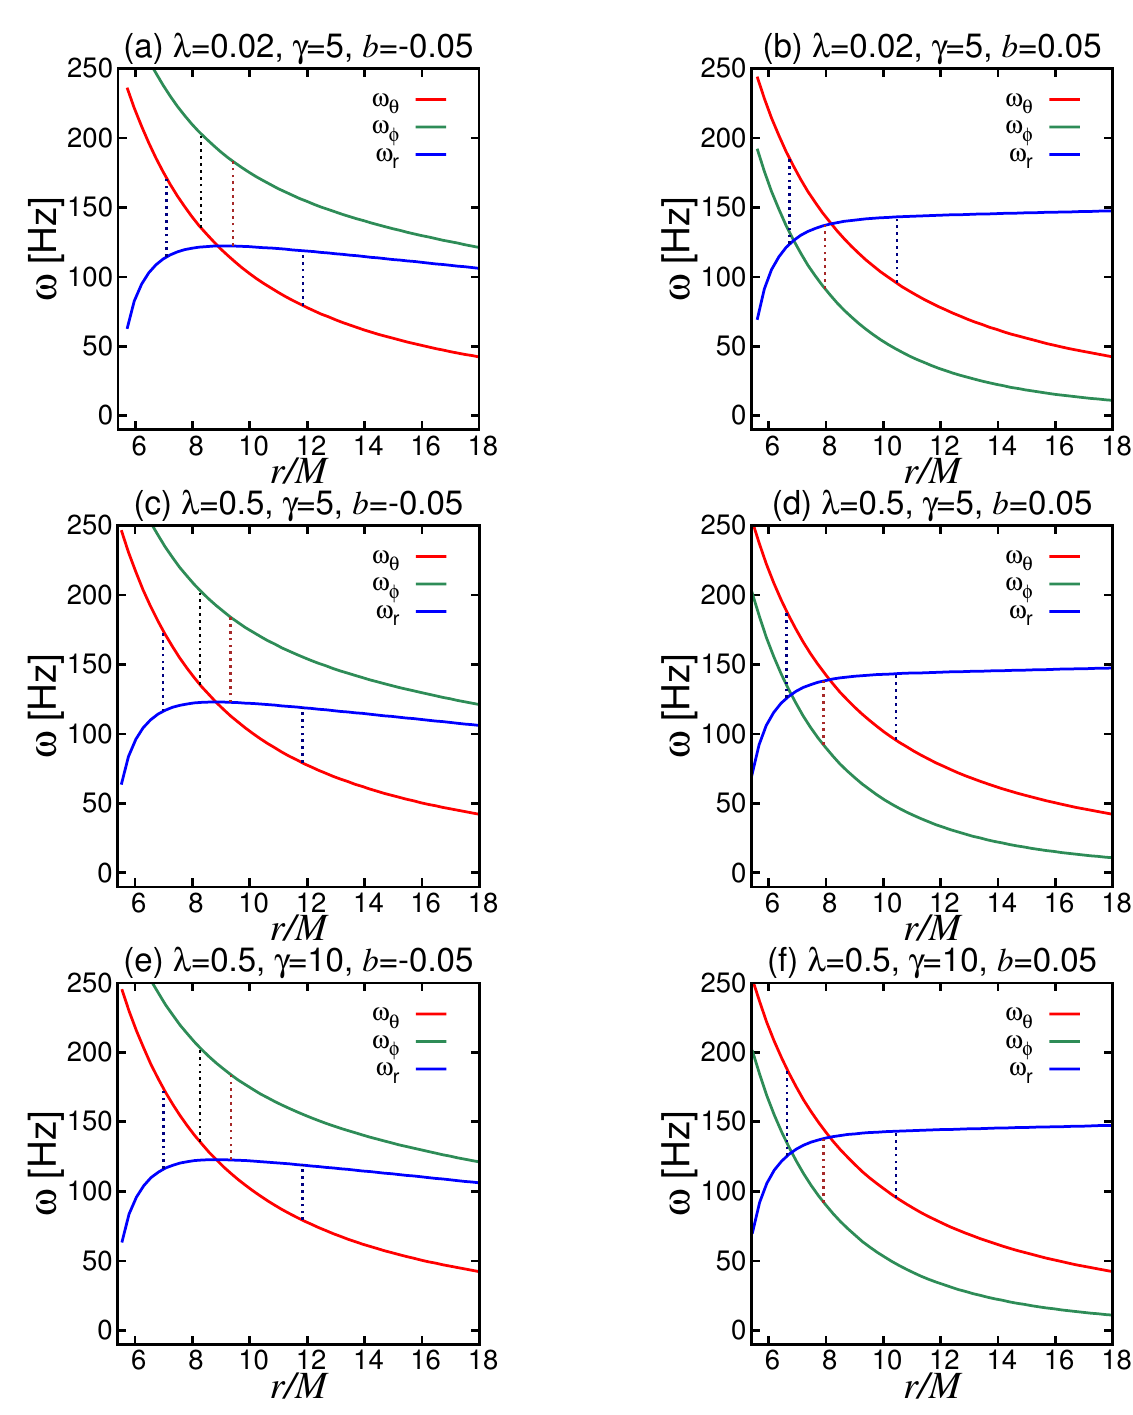
Figure 10. The epicyclic frequencies for RGISBHs immersed in an external uniform magnetic field by taking M / M (cid:12) = 10. Blue dotted vertical lines denote the positions of the 3:2 resonance between ω θ and ω r ; brown dotted vertical lines denote the ones of the 3:2 resonance between ω φ and ω r ; black dotted vertical lines denote the ones between ω φ and ω θ